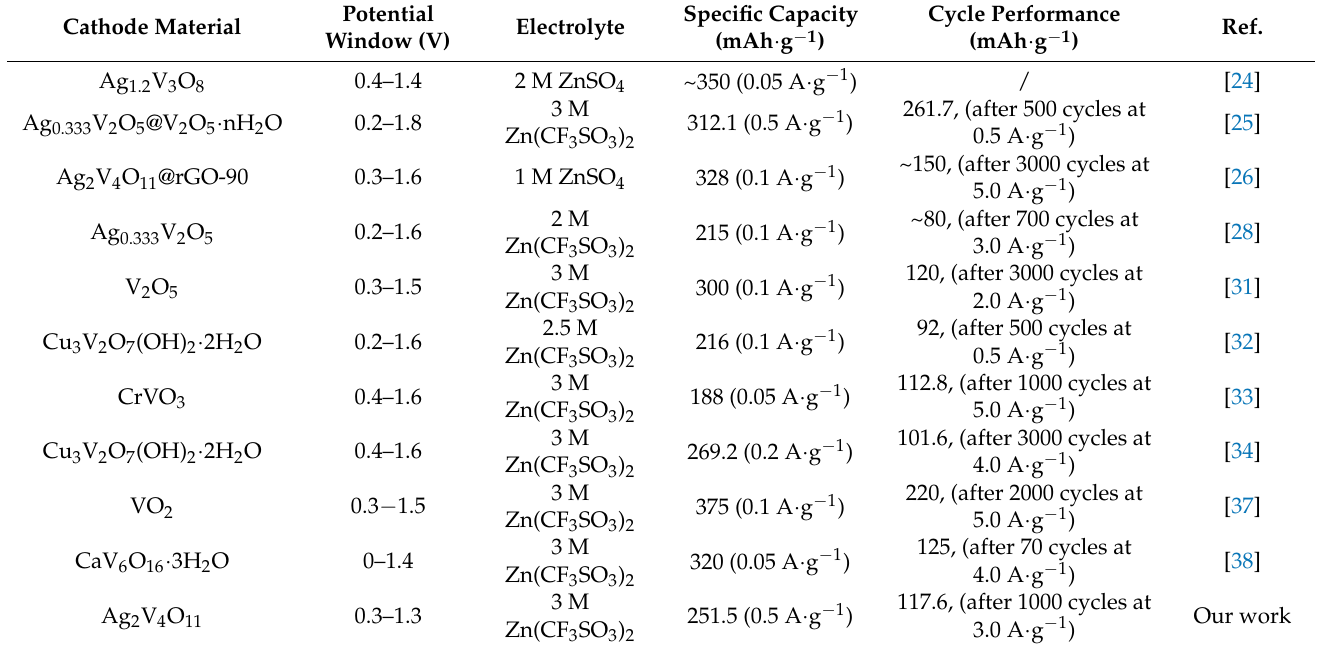
Table 1. Summary of electrochemical performance of cathode materials in